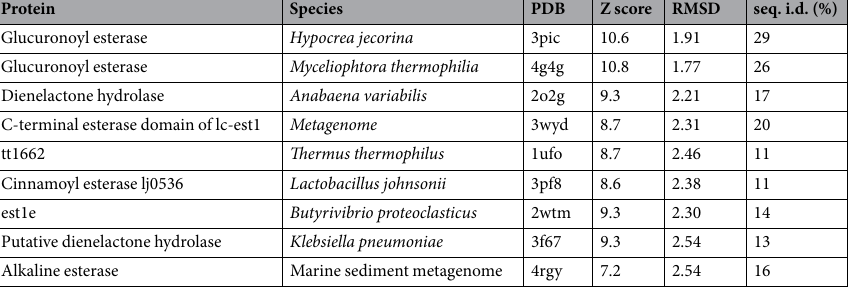
Table 1. Structural homologs of MZ0003 aligned using PDBefold. The Z-score is the significance of the alignment based on Gaussian statistics; Root-mean-square deviation (RMSD) is calculated between C α atoms; % sequence identity (seq.i.d.) is the percentage of structurally aligned positions with identical